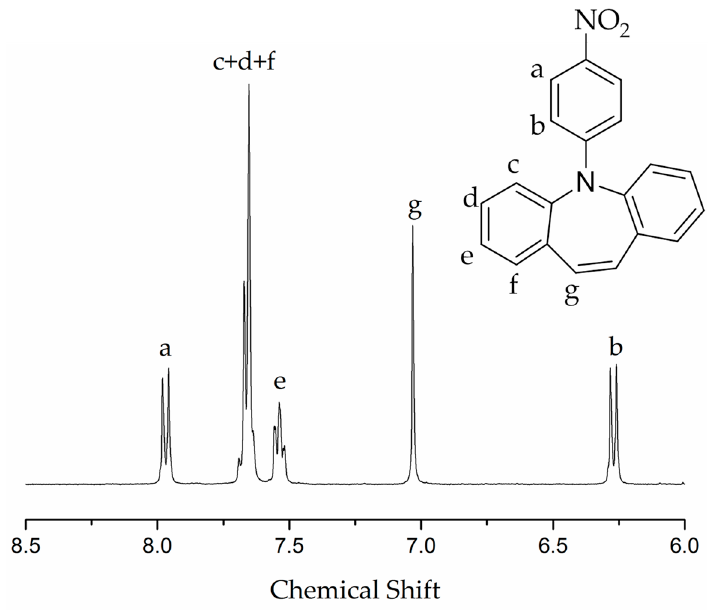
Figure A1. 1 H NMR spectrum of M1 in DMSO- d 6 .